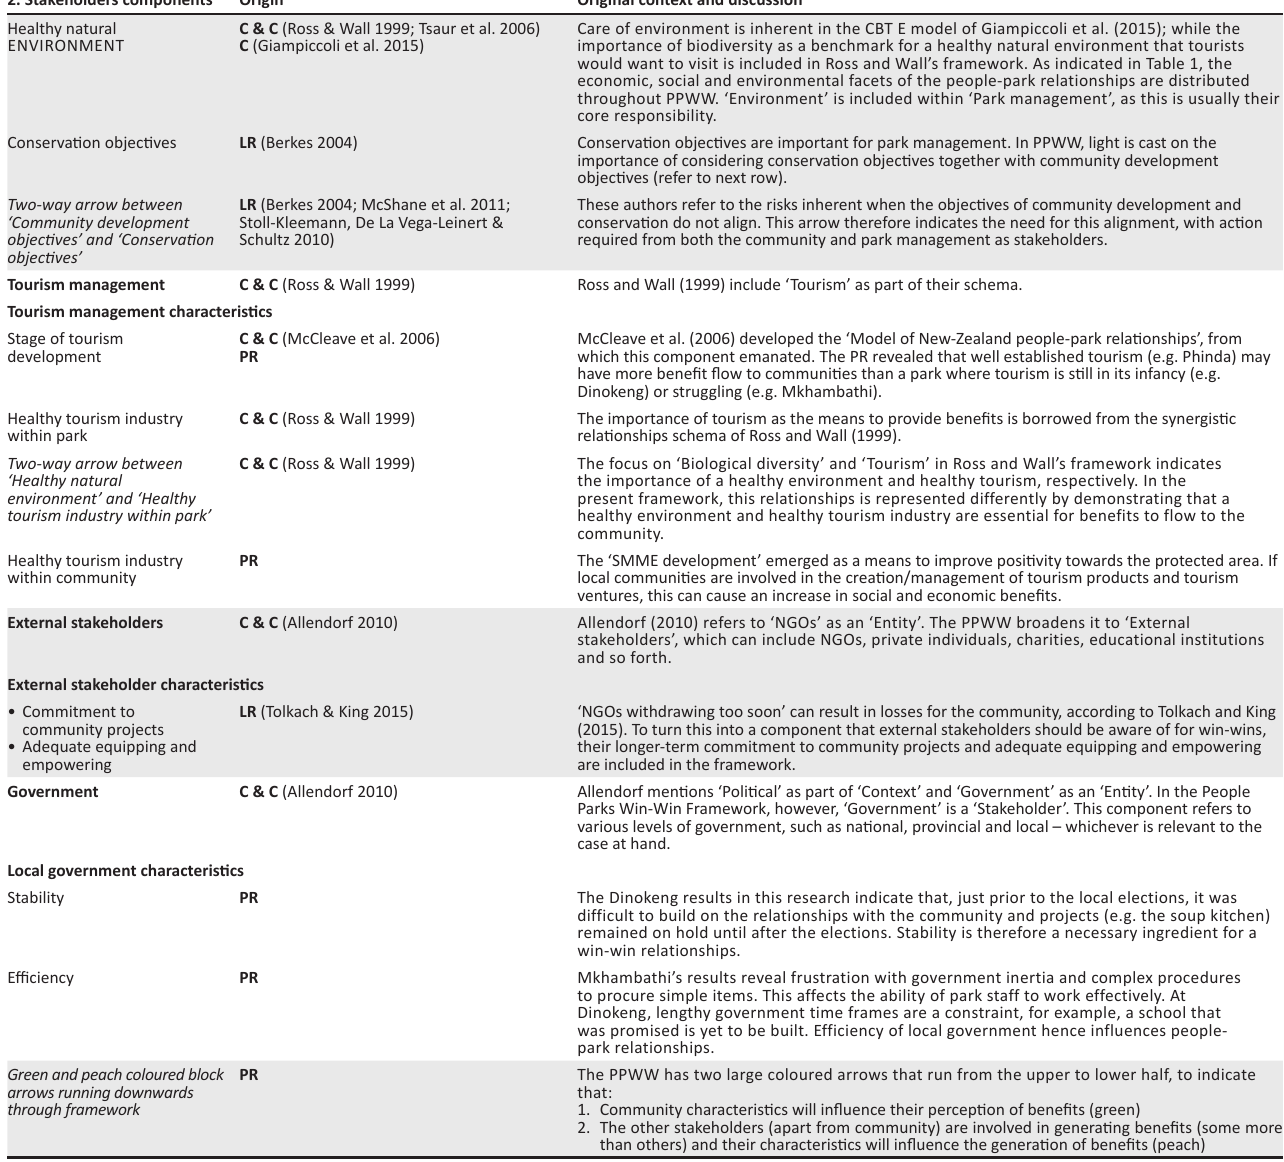
TABLE 2 (Continues...): Layer 2 and components used to build the People Parks Win-Win Framework.